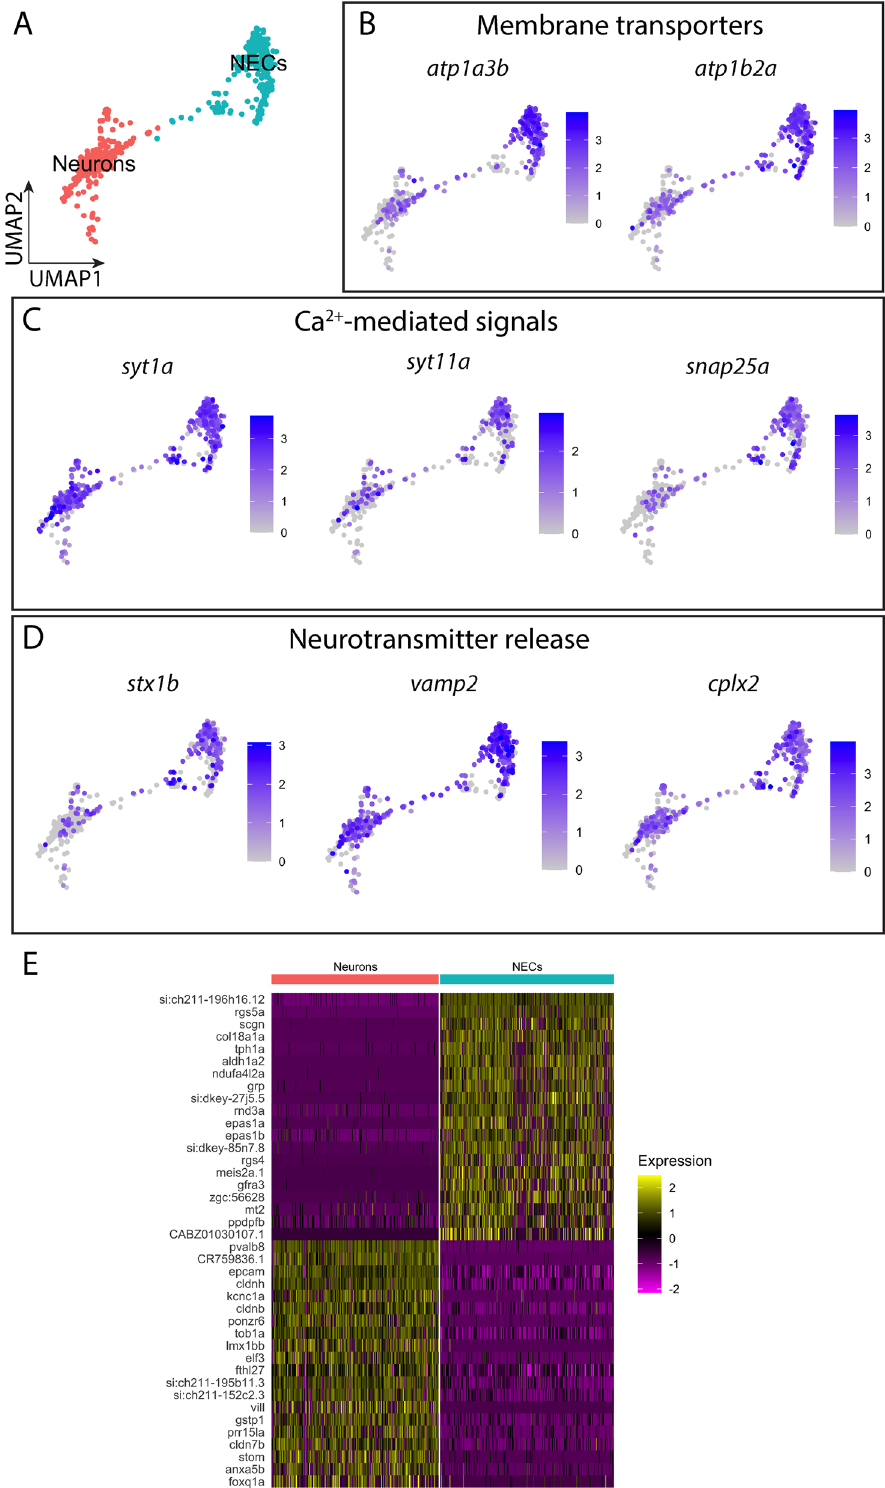
Figure 4. Comparison of gene expression between the NEC and neuron clusters. ( A ) UMAP plot showing the subset of the cell population containing NECs and neurons only. ( B ) UMAP plots showing the log-normalized expression of genes encoding membrane transporters. ( C ) UMAP plots showing the log-normalized expression of genes involved in Ca 2+ -mediated signals. ( D ) UMAP plots showing the log-normalized expression of genes involved in neurotransmitter release. ( E ) Heatmap of the top 20 highly differentially expressed genes in NECs and neurons. Scaled gene expression is shown by colours, where yellow indicates relatively high expression and purple indicates relatively low expression. See text and Tables 1 and 2 for gene